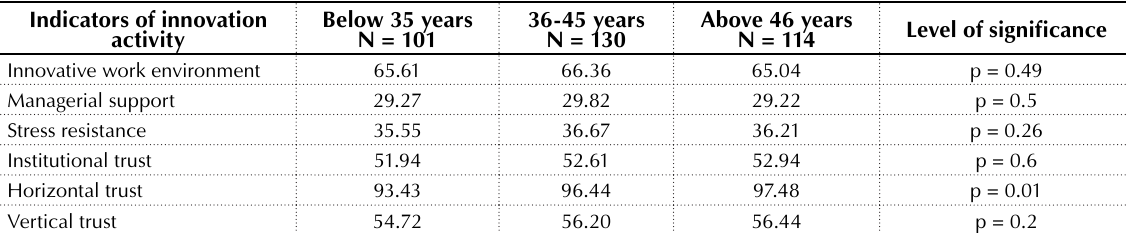
Source: Calculated by the